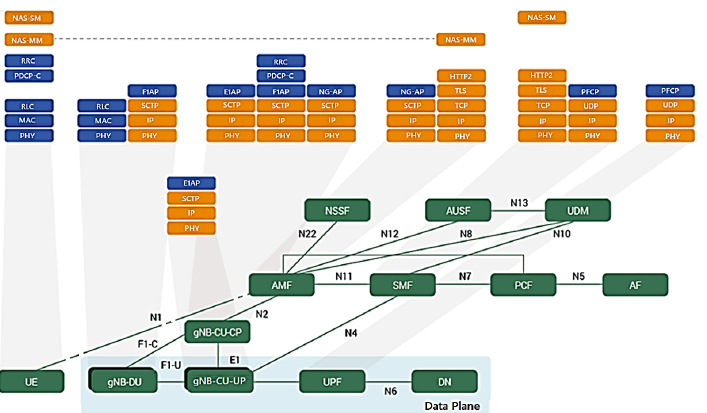
Figure 10. Architecture of the core 5G SBA and reference point with the end-to-end control plane protocol stack and its main interfaces. Based on [51].